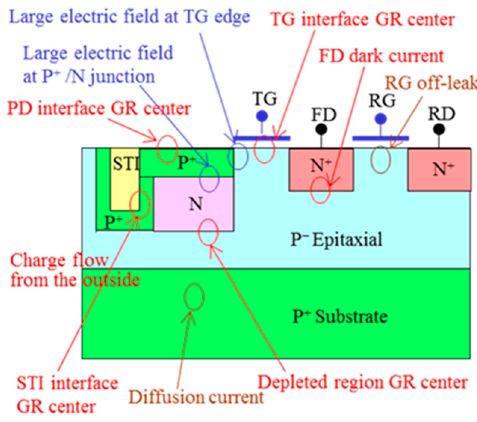
Figure 3. Various possible causes of dark current generation, illustrated in CMOS image sensor pixel cross-section. PD: photodiode; TG: transfer gate; FD: floating diffusion; RG: reset gate; RD: reset drain; GR center: generation recombination center; STI: shallow trench isolation.